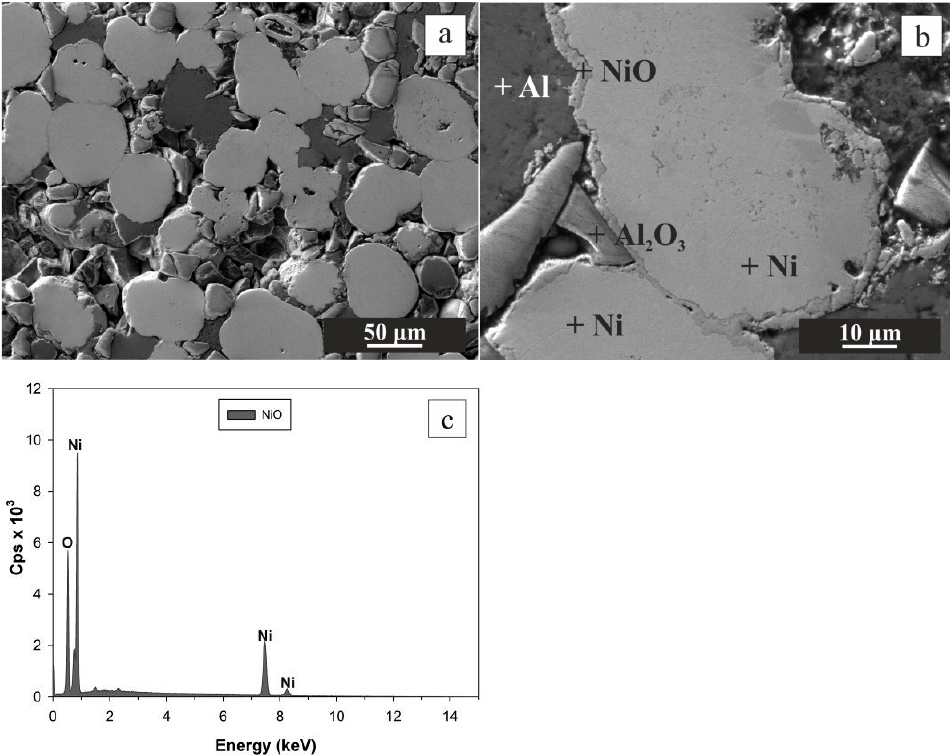
Figure 4. SEM images from the central region of the oxidized CIP green tablet at magnification 300× ( a ) and 1500× ( b ). Thermal oxidation was performed in an oven at the final temperature of 600 °C. The phases, determined by EDS, are denoted by the cross ( b ). EDS spectra were obtained by point analysis in NiO ( c ).